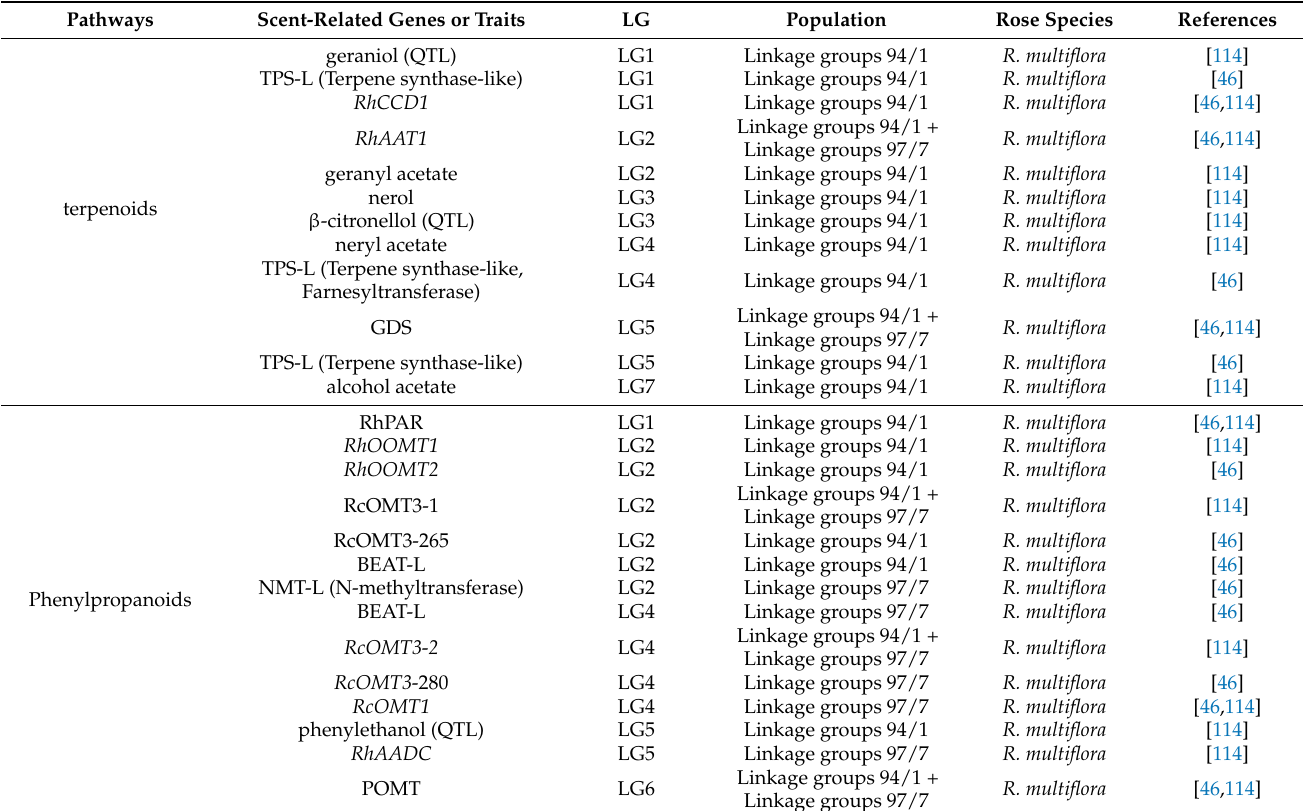
Table 3. Phenotypic and genotypic traits, available on the consensus map in